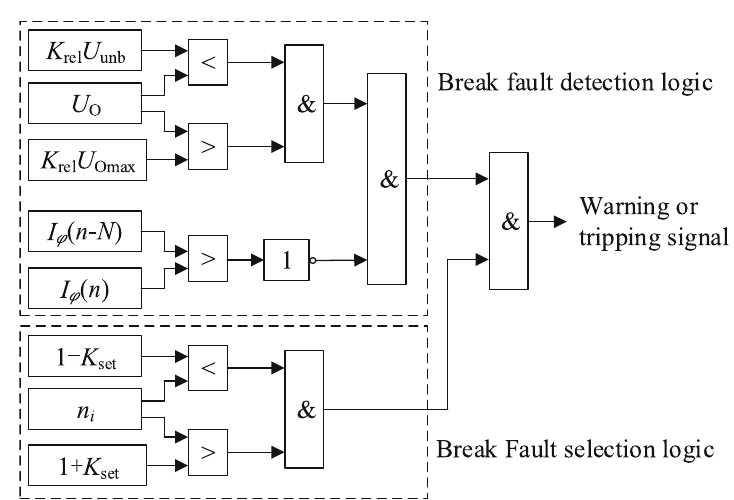
Fig. 3 Logic diagram of single-phase break fault